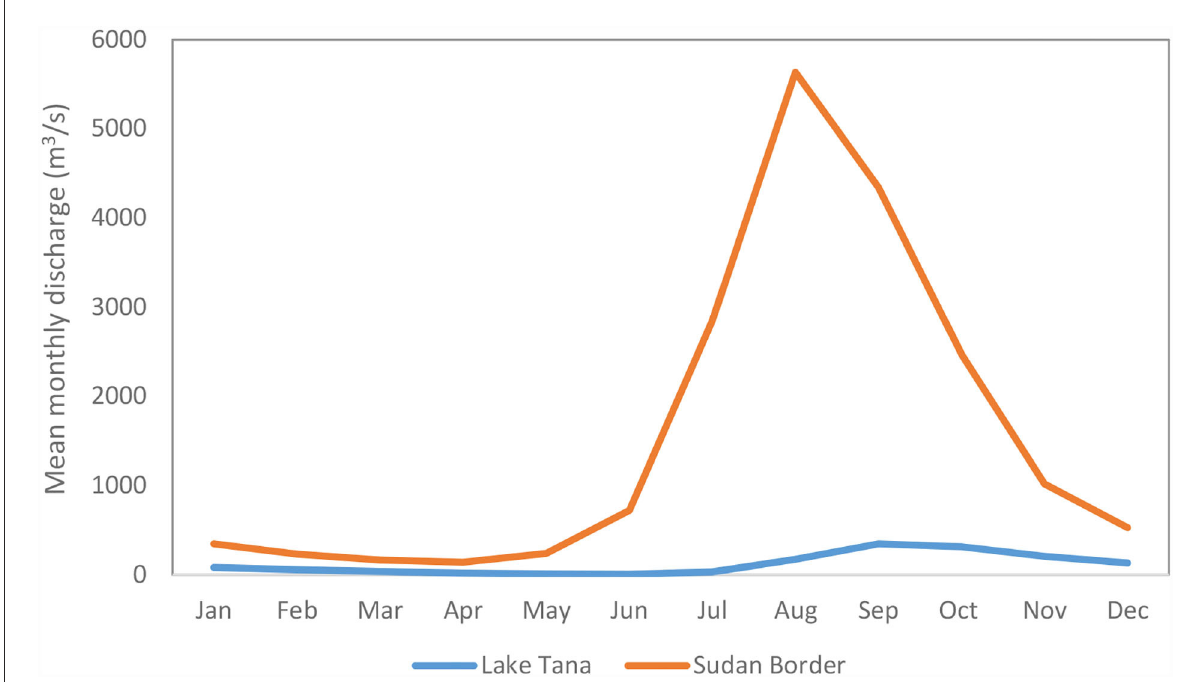
FIGURE7 Mean monthly discharge of the Abbay river at the Lake Tana and the Ethiopian/Sudan Border (m 3 /s). Source (ABDO, 2020).